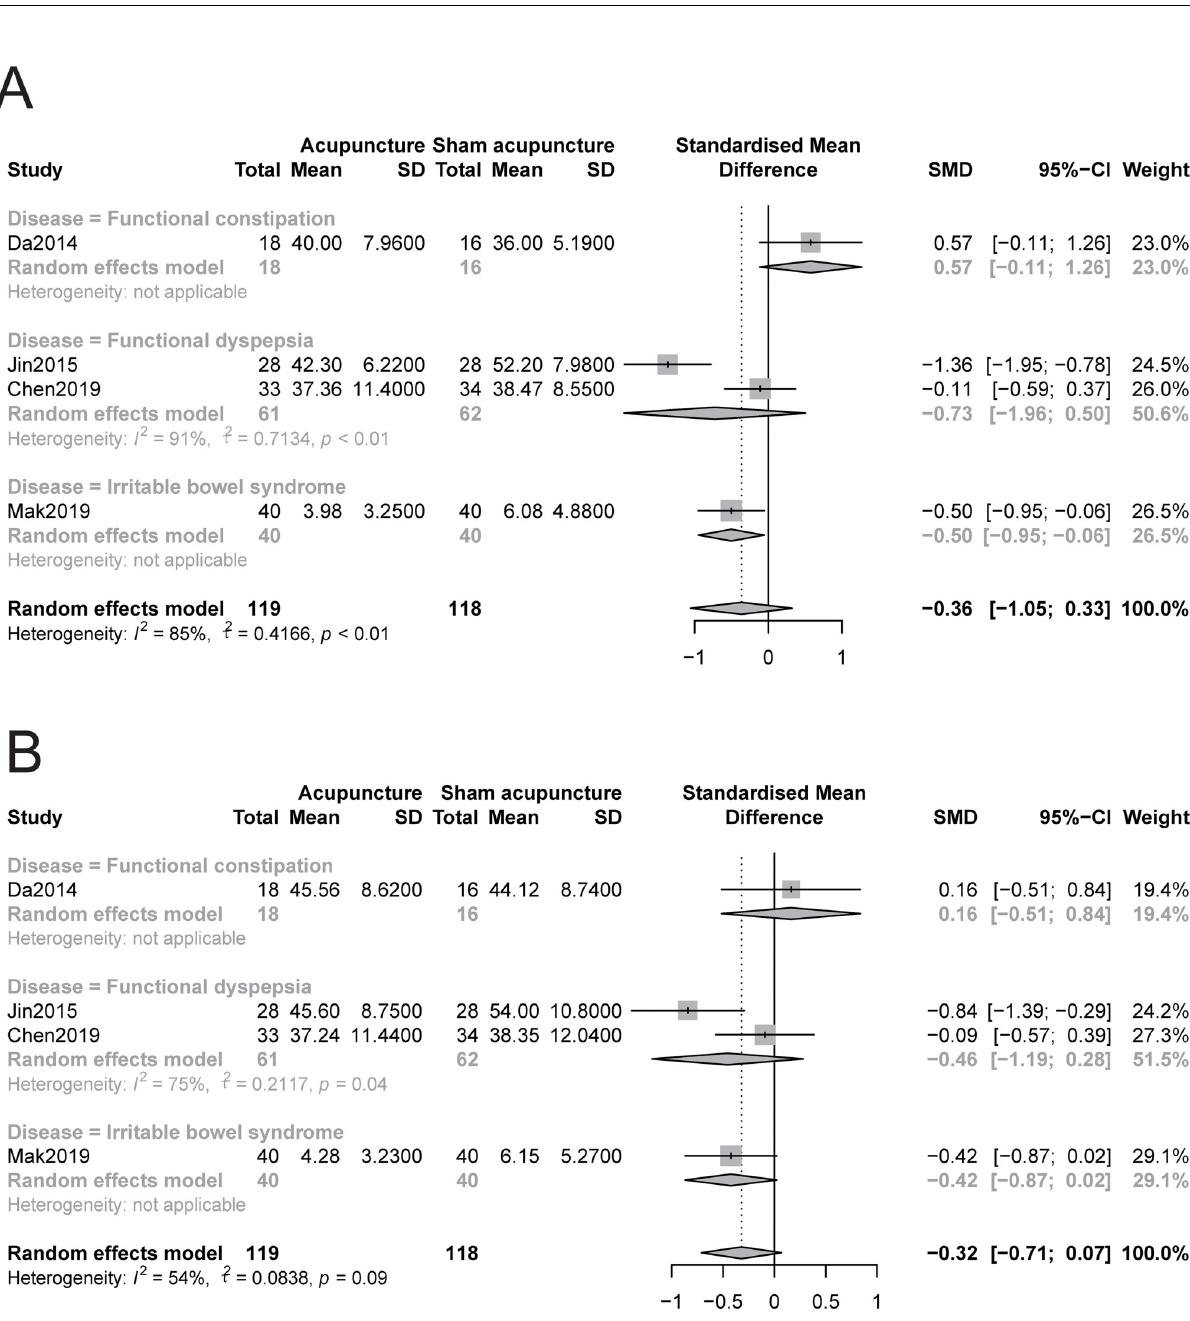
PLOS ONE | https://doi.org/10.1371/journal.pone.0263166 January 27,